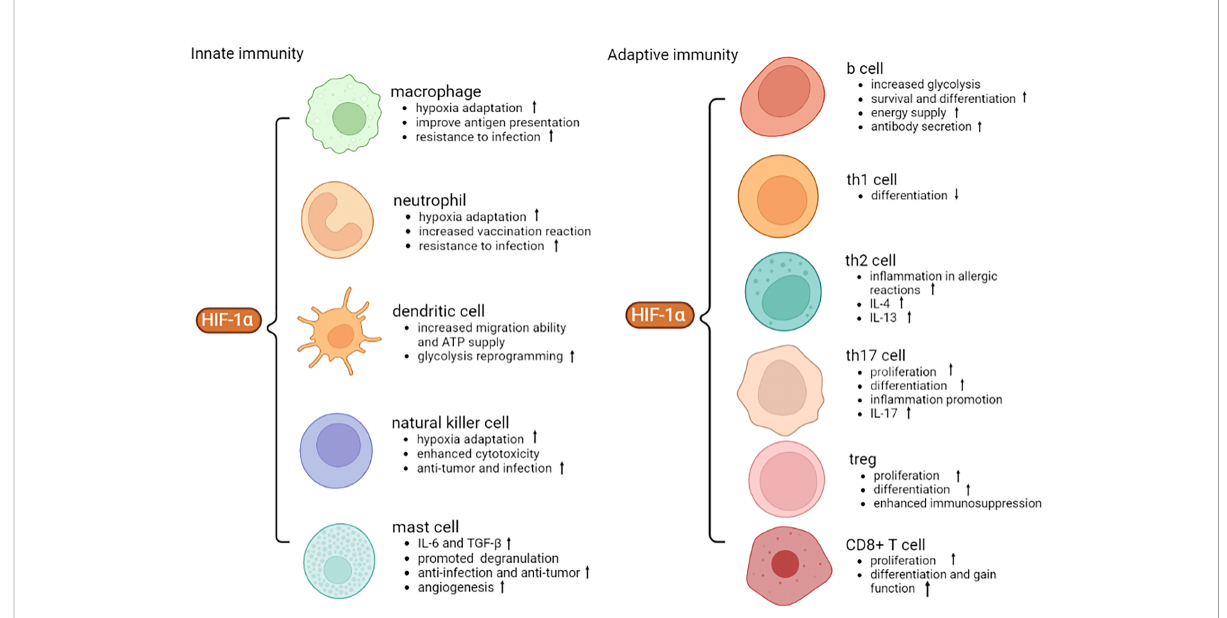
FIGURE 2 Role of HIF-1 a in different immune cells. HIF-1 a facilitates anti-infection, anti-tumor and hypoxic adaptation of innate immunity. HIF-1 a promotes the proliferation and differentiation of adaptive immune cells and secretion of in fl ammatory cytokines. VEGF, vascular endothelial growth factor; ATP, adenosine triphosphate; IL-4, interleukin-4; TGF- b , transforming growth factor- b